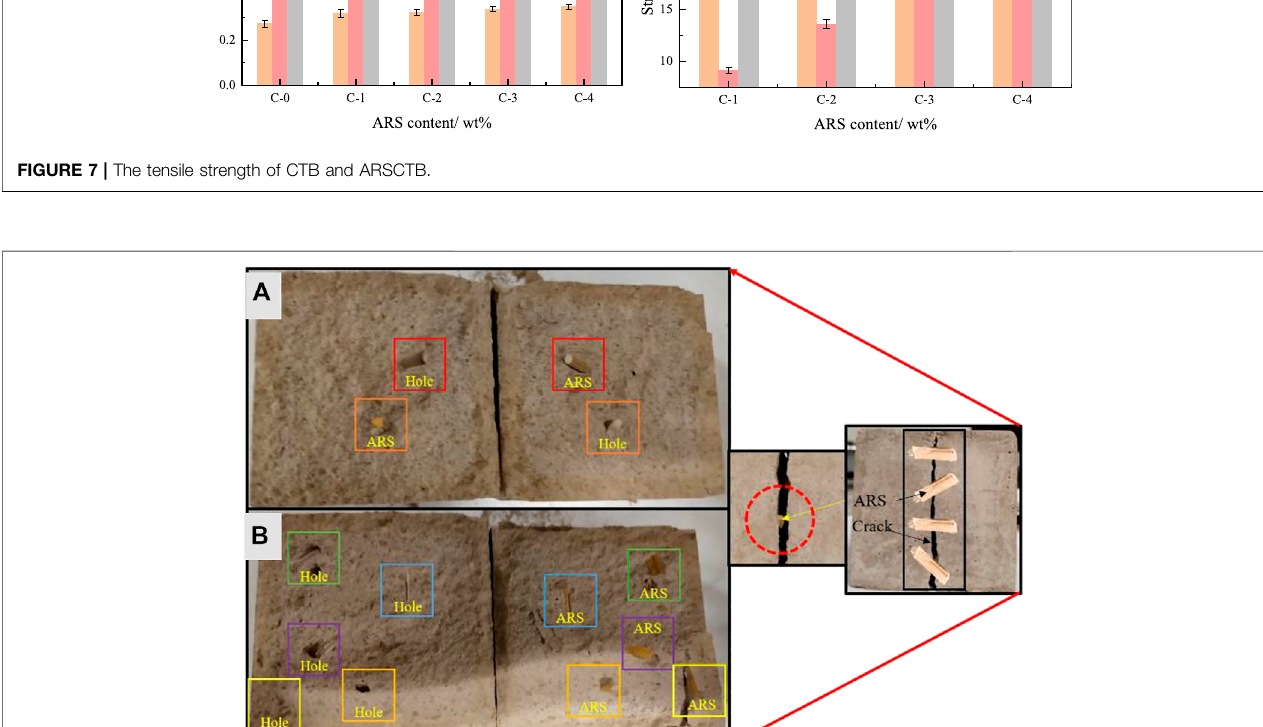
FIGURE 8 | The split surface of ARSCTB (a: 0.1 wt%, 0.4 wt%).